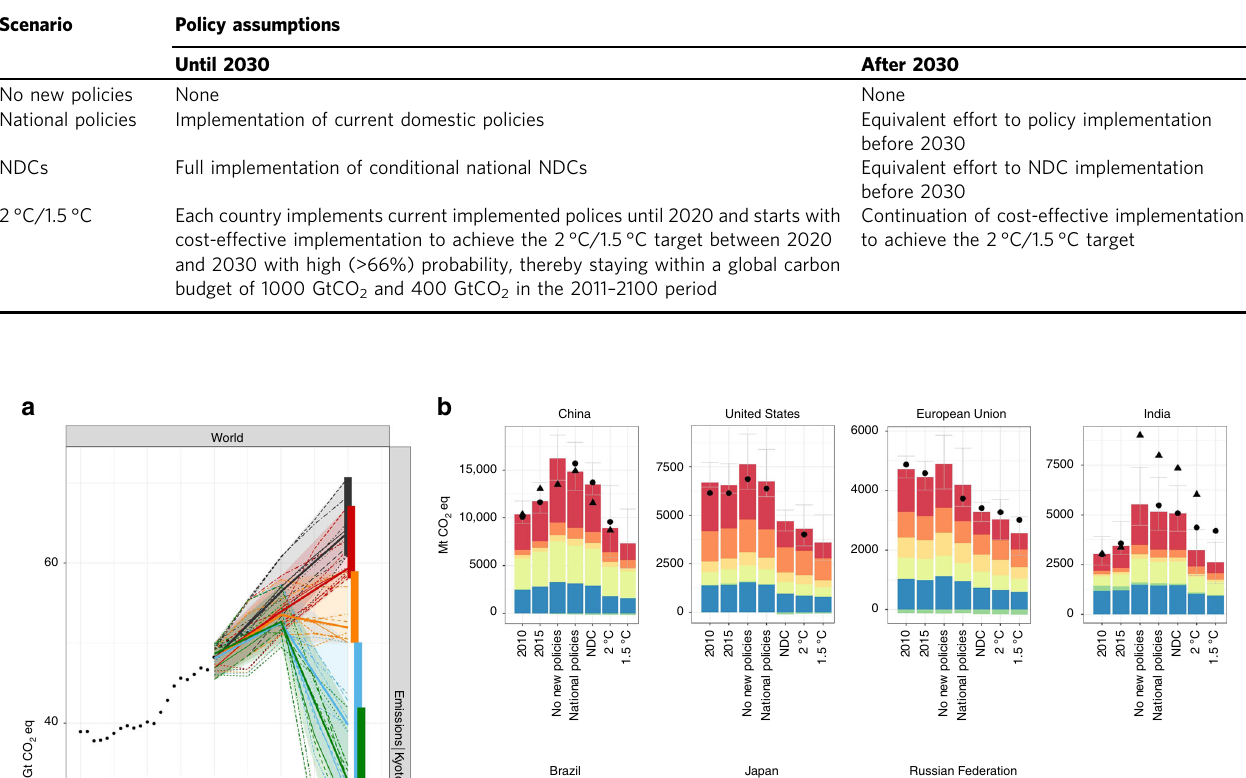
Table 1 Main assumptions on climate policy implementation per scenario.